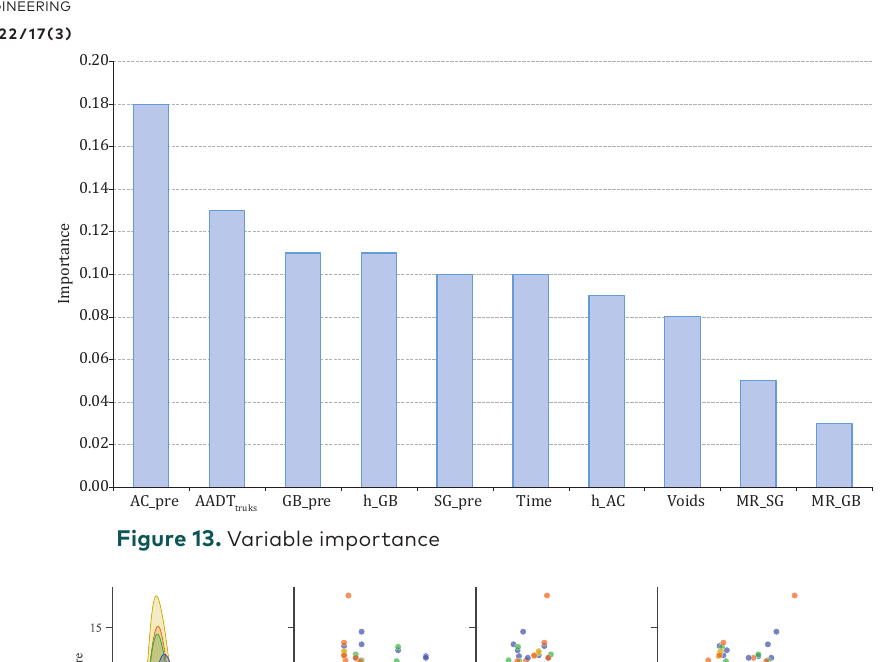
Figure 13. Variable